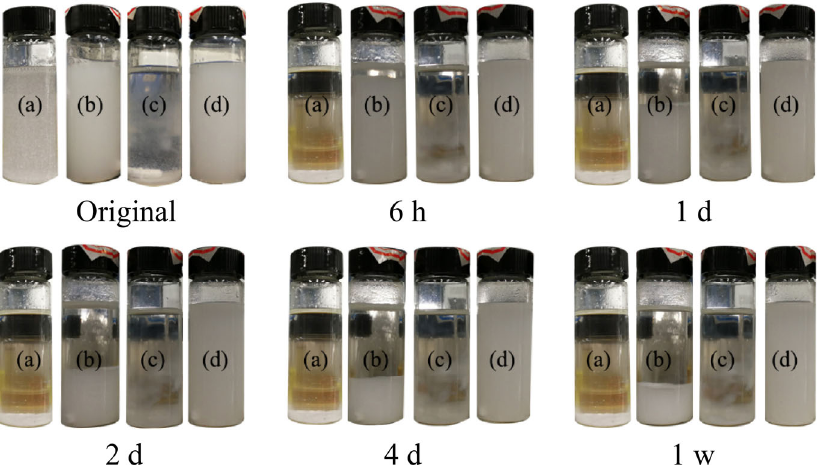
Fig. 6 Dispersion test results: photographs of 1.0 wt% (a) pristine  -ZrP, (b) HA_  -ZrP, (c) DGA_  -ZrP, and (d) OA_  -ZrP nanosheets in mineral